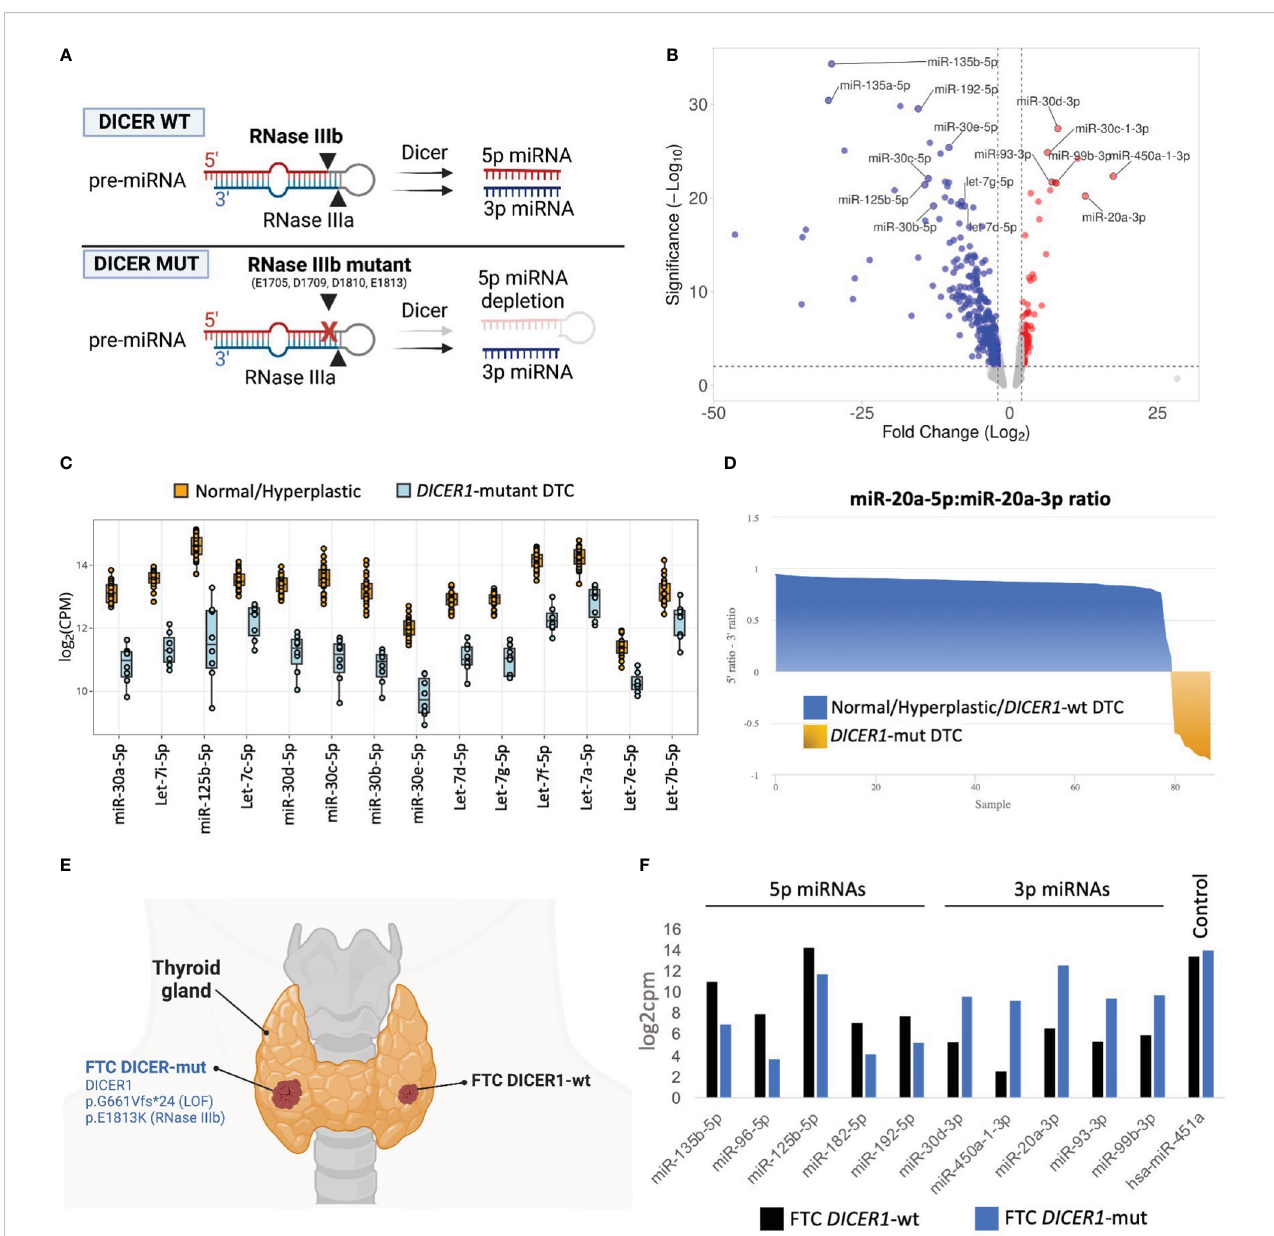
FIGURE 1 miRNA dysregulation in thyroid cancers harboring hotspot mutations in DICER1 RNase IIIb domain. (A) Scheme illustrating the mechanism by which the two RNase III domains of DICER1 cleave a pre-miRNA hairpin, and for speci fi c loss of 5p miRNAs in RNase IIIb hotspot mutants. (B) Volcano plot highlighting miRNAs differentially expressed between 8 differentiated thyroid cancers harboring RNase IIIb mutations and 26 non-neoplastic/hyperplastic cases. Analysis shows general downregulation of 5p miRNAs and upregulation of 3p miRNAs. (C) Differential expression of selected miRNAs well-known for their tumor suppressor function in cancer, including let-7 and miR-30 families and miR-125b-5p. (D) Analysis of miR-20a pre-miRNA strand processing (5p:3p ratio) across normal/hyperplastic, DICER1 -wt tumors and DICER1 -mut tumors. The tumors with hotspot mutations of DICER1 (shown in yellow) exhibit selective defects in processing 5p miRNA strands (but not 3p), leading to overall decrease in 5p:3p strand ratios. (E) Scheme of patient diagnosed with bilateral follicular thyroid cancer (FTC), one with DICER1 RNase IIIb and one, DICER1 -wt. Created with BioRender.com. (F) The 2 FTCs from the same patient show remarkable differences in miRNAs levels. DICER1 -mut FTC (right lobe) shows reduction in 5p miRNAs and upregulation of 3p miRNAs when compared to DICER1 -wt FTC (left